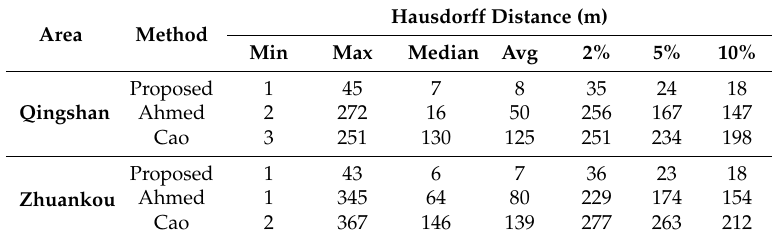
Table 2. Hausdorff distance measure evaluation.